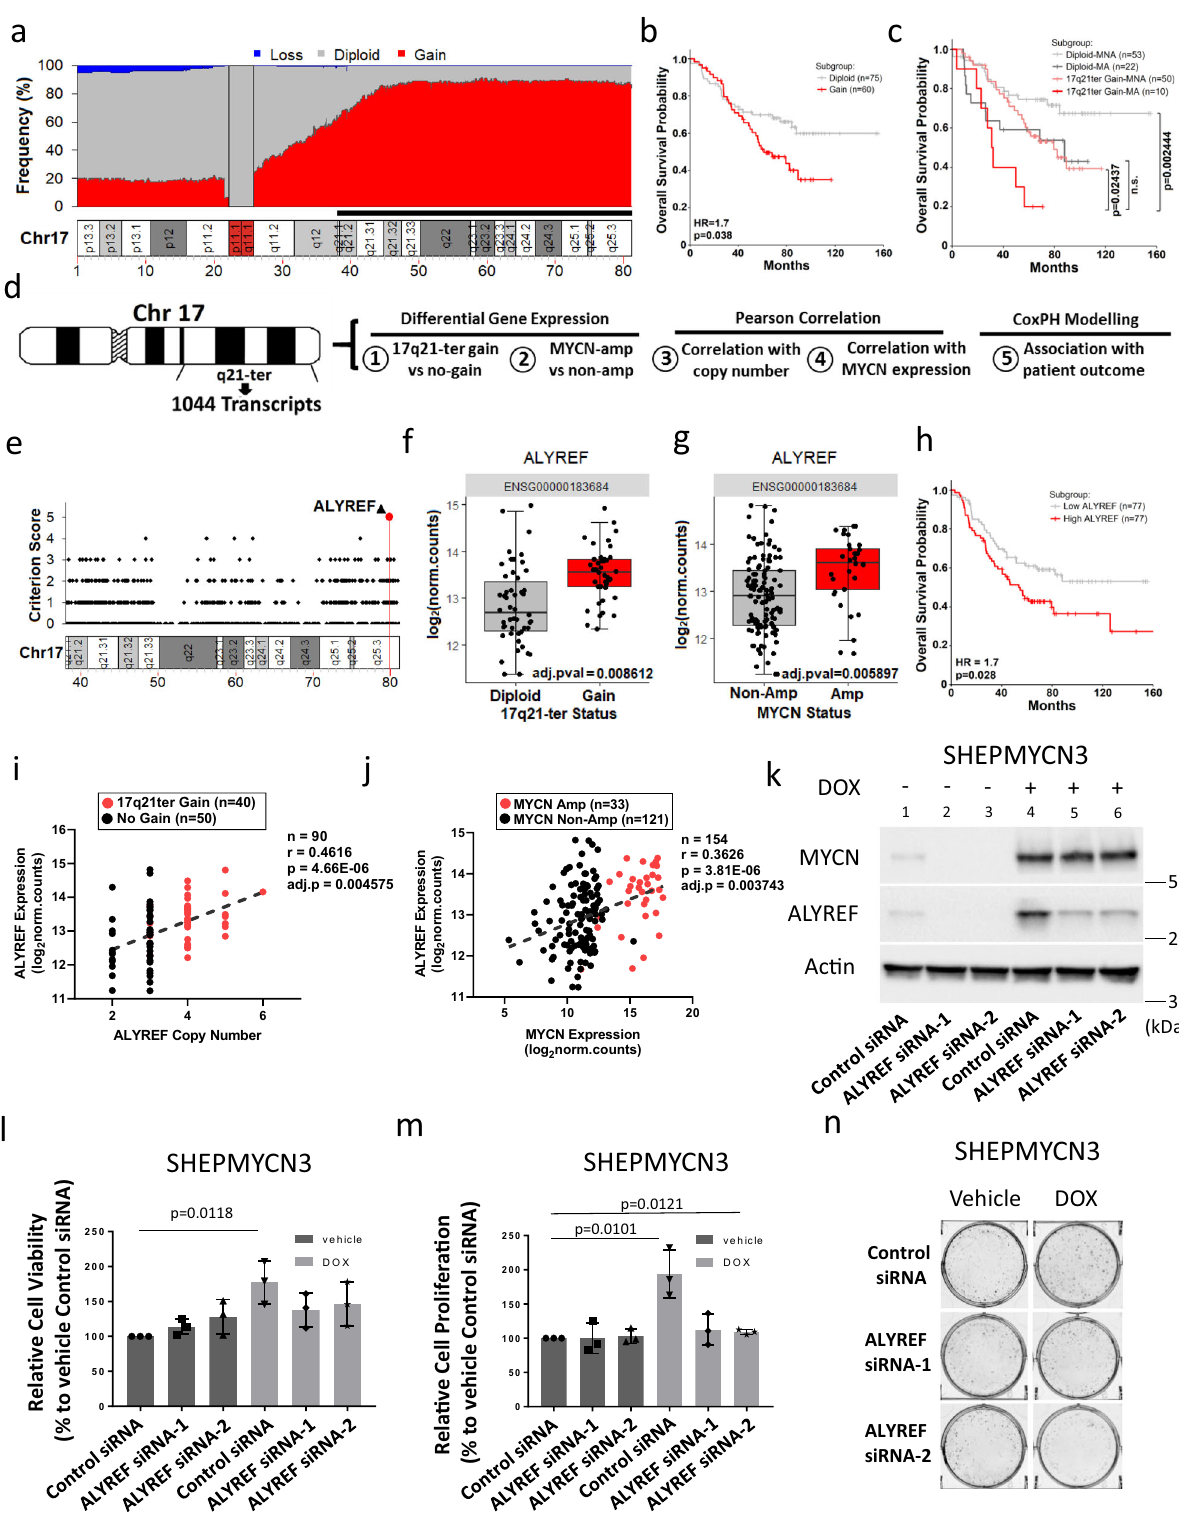
phenotypic effect of ALYREF knockdown on human SHEP- MYCN3 neuroblastoma cells, which permits doxycycline- inducible overexpression of stably incorporated MYCN, and are therefore ideal for MYCN gene dependency experiments. SHEPMYCN3 cells were transfected with control siRNA, ALYREF siRNA-1, or ALYREF siRNA-2 (Fig. 1k) for 72 h with (lanes 4 – 6) and without doxycycline (lanes 1 – 3). As expected,